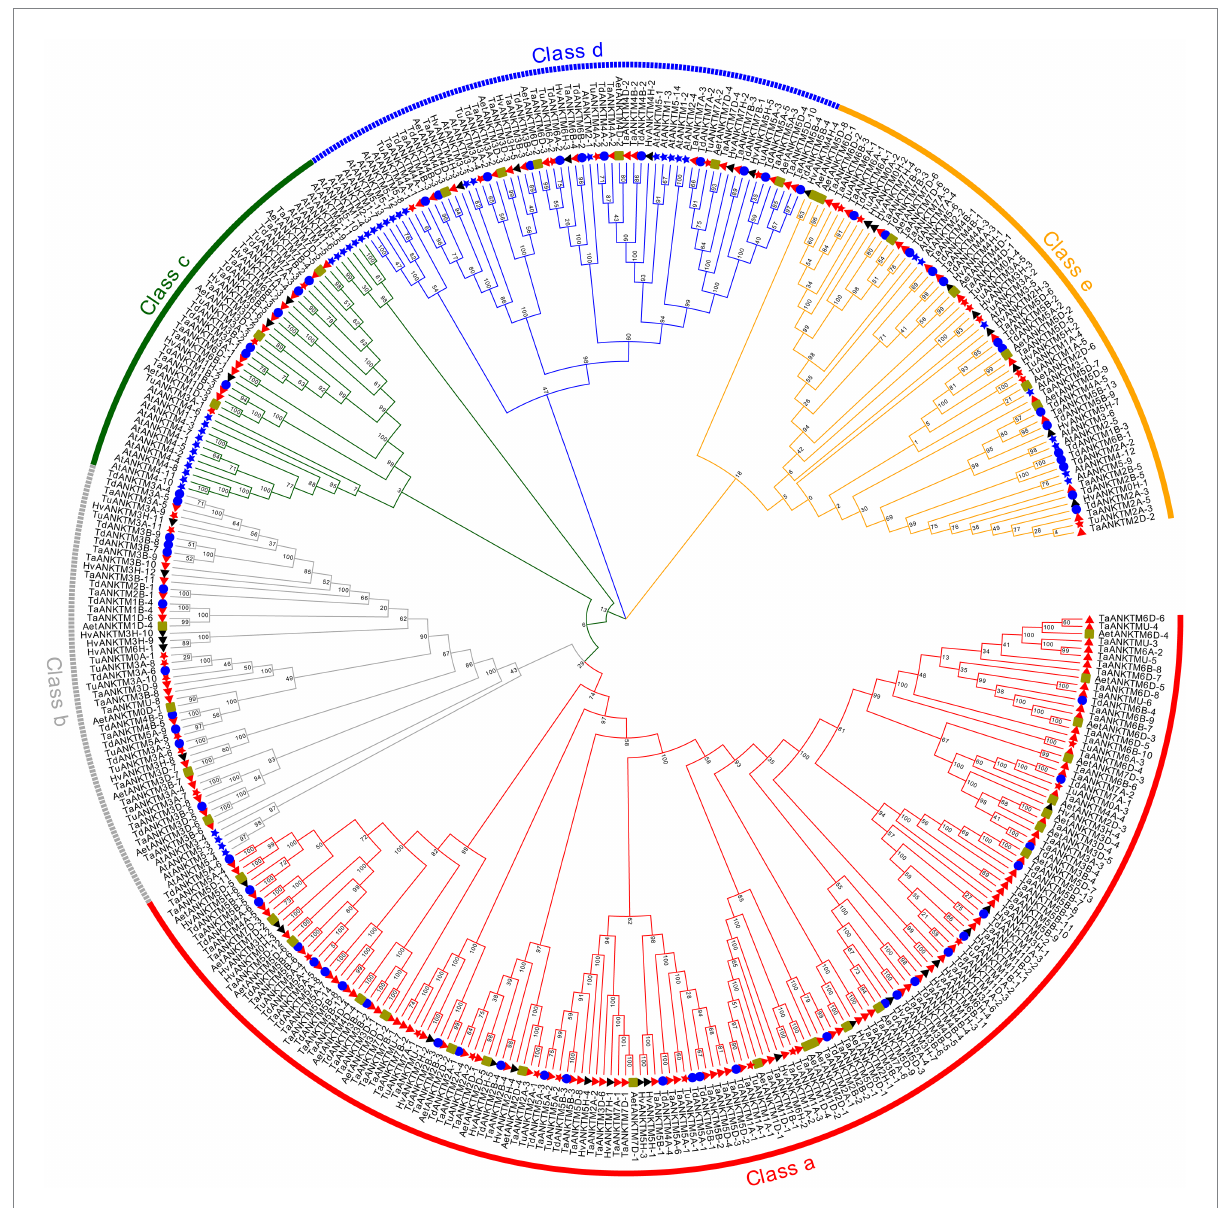
FIGURE 1 Phylogenetic relationship analysis of 381 ANKTM proteins from Triticum aestivum , Triticum dicoccoides , Aegilops tauschii , Triticum urartu , H. vulgare and Arabidopsis. The phylogenetic tree was built using the Maximum likelihood method with 1,000 bootstrap replicates by MEGA X. The diverse classes of ANKTM proteins were marked with different colors. The ANKTM proteins of T. aestivum , T. dicoccoides , A. tauschii , T. urartu, H. vulgare , and Arabidopsis were represented by red triangles, blue circles, yellow squares, red stars, black triangles and blue stars, respectively. Gene IDs of all the analyzed genes can be found in Supplementary Table